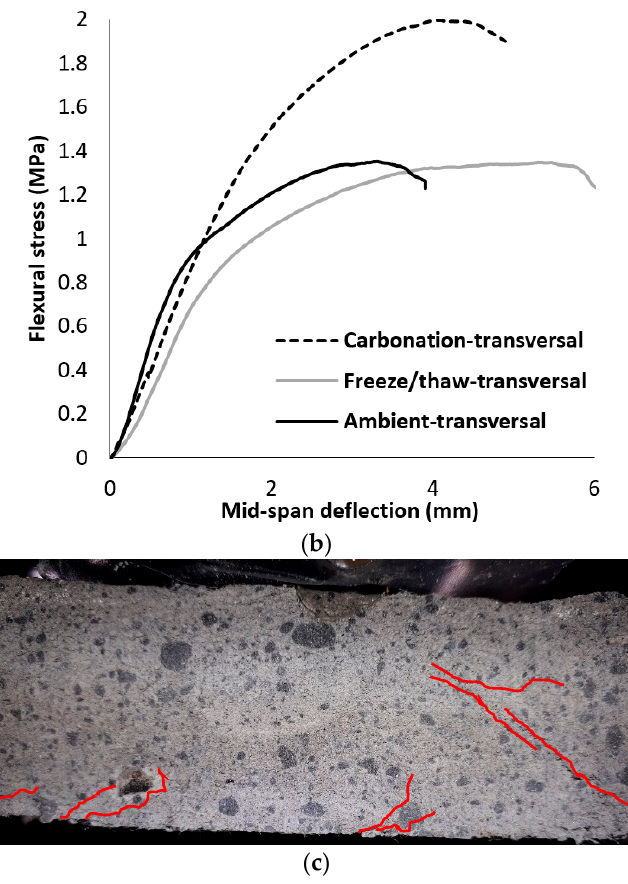
Figure 9. Effects of fiber orientation on the flexural performance of the prismatic beams: ( a ) extracted in the longitudinal direction; ( b ) extracted in the transversal direction; ( c ) crack patterns.